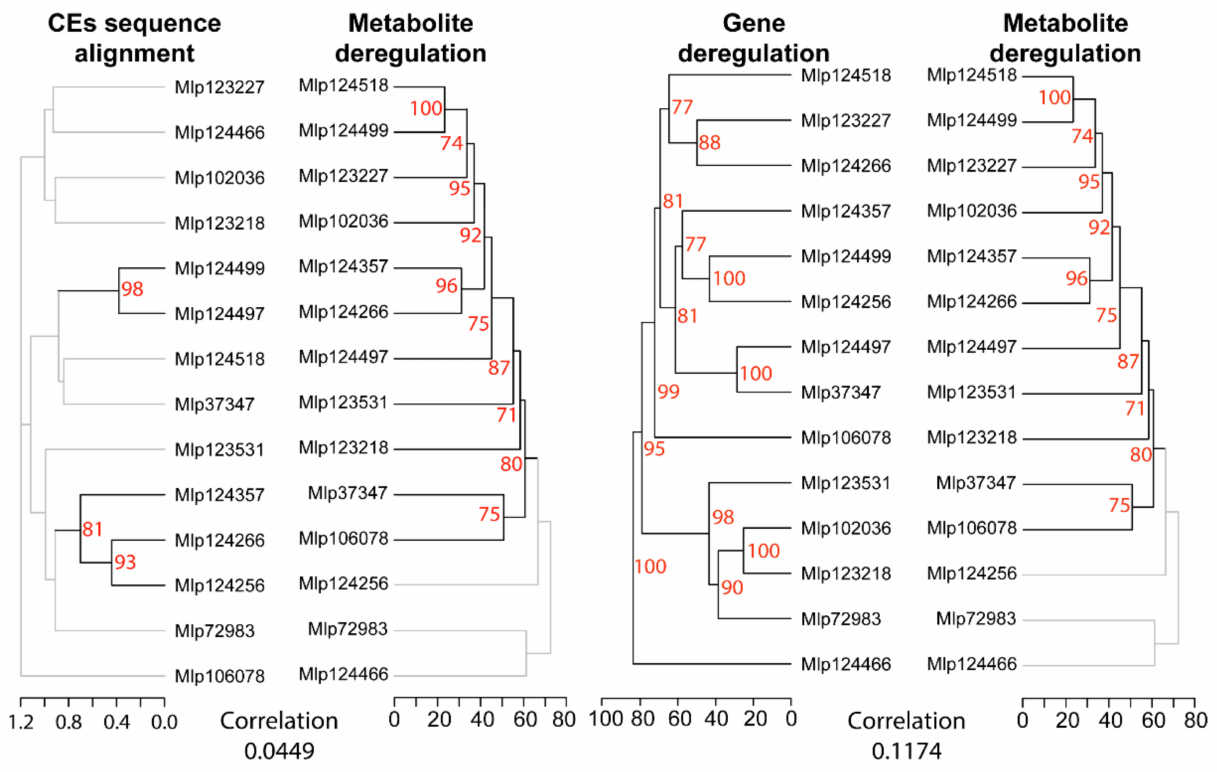
Figure 7. Pearson’s correlation of transgenic lines based on metabolite deregulation groups effectors independently of amino acid sequence homology, and gene deregulation patterns are not correlated to metabolite deregulation pat- terns in CE-expressing lines. The comparison between the dendrogram obtained from CE sequence alignment (multiple sequence alignment with Muscle of CEs without signal peptide and a tree computed with UPGMA, left ) and the dendro- gram of transgenic lines based on metabolite deregulation ( middle ) shows low correlation (correlation value on the left ). Similarly, comparison between the dendrogram of transgenic lines based on metabolite deregulation and the one based on gene deregulation ( right ) shows a lack of correlation (correlation value on the right ). Dendrograms based on correlation of metabolite deregulation or gene deregulation were calculated with Pearson’s correlation coefficient of fold Change levels and bootstrap values were obtained with pvclust. Branches with bootstrap support < 70% are shown in grey. The underlying data for this figure can be found in the study by dos Santos et al.